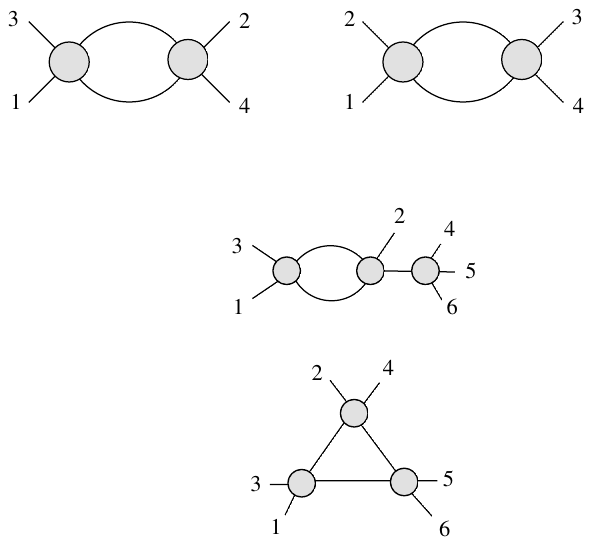
Figure 3 . The Feynman diagrams contributing to four- and six-point fermionic amplitudes in K-S action at one loop. One should also sum over all other independent